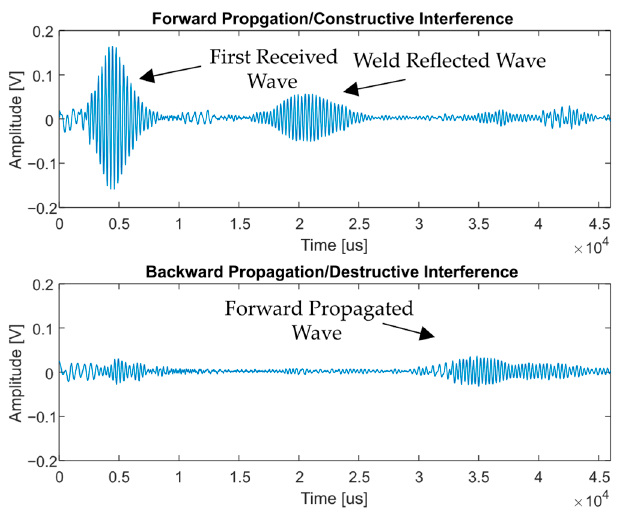
Figure 9. The forward propagating waves and the backward propagating waves are shown. The difference in amplitude shows that unidirectional transmission has been achieved experimentally. The signal at 3.5 µ s in the backward propagating signal is a reflected signal from the forward propagating wave.